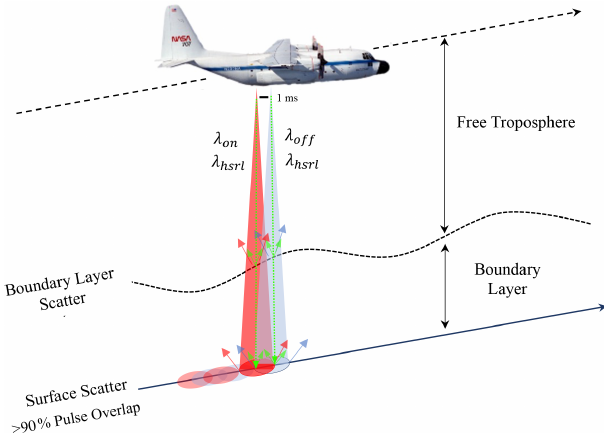
Figure 1. HALO measurement geometry from the NASA C-130. Simultaneous acquisition of CH 4 DIAL–IPDA and HSRL data pro- vides information about column CH 4 and aerosols/PBLH, respec- tively.